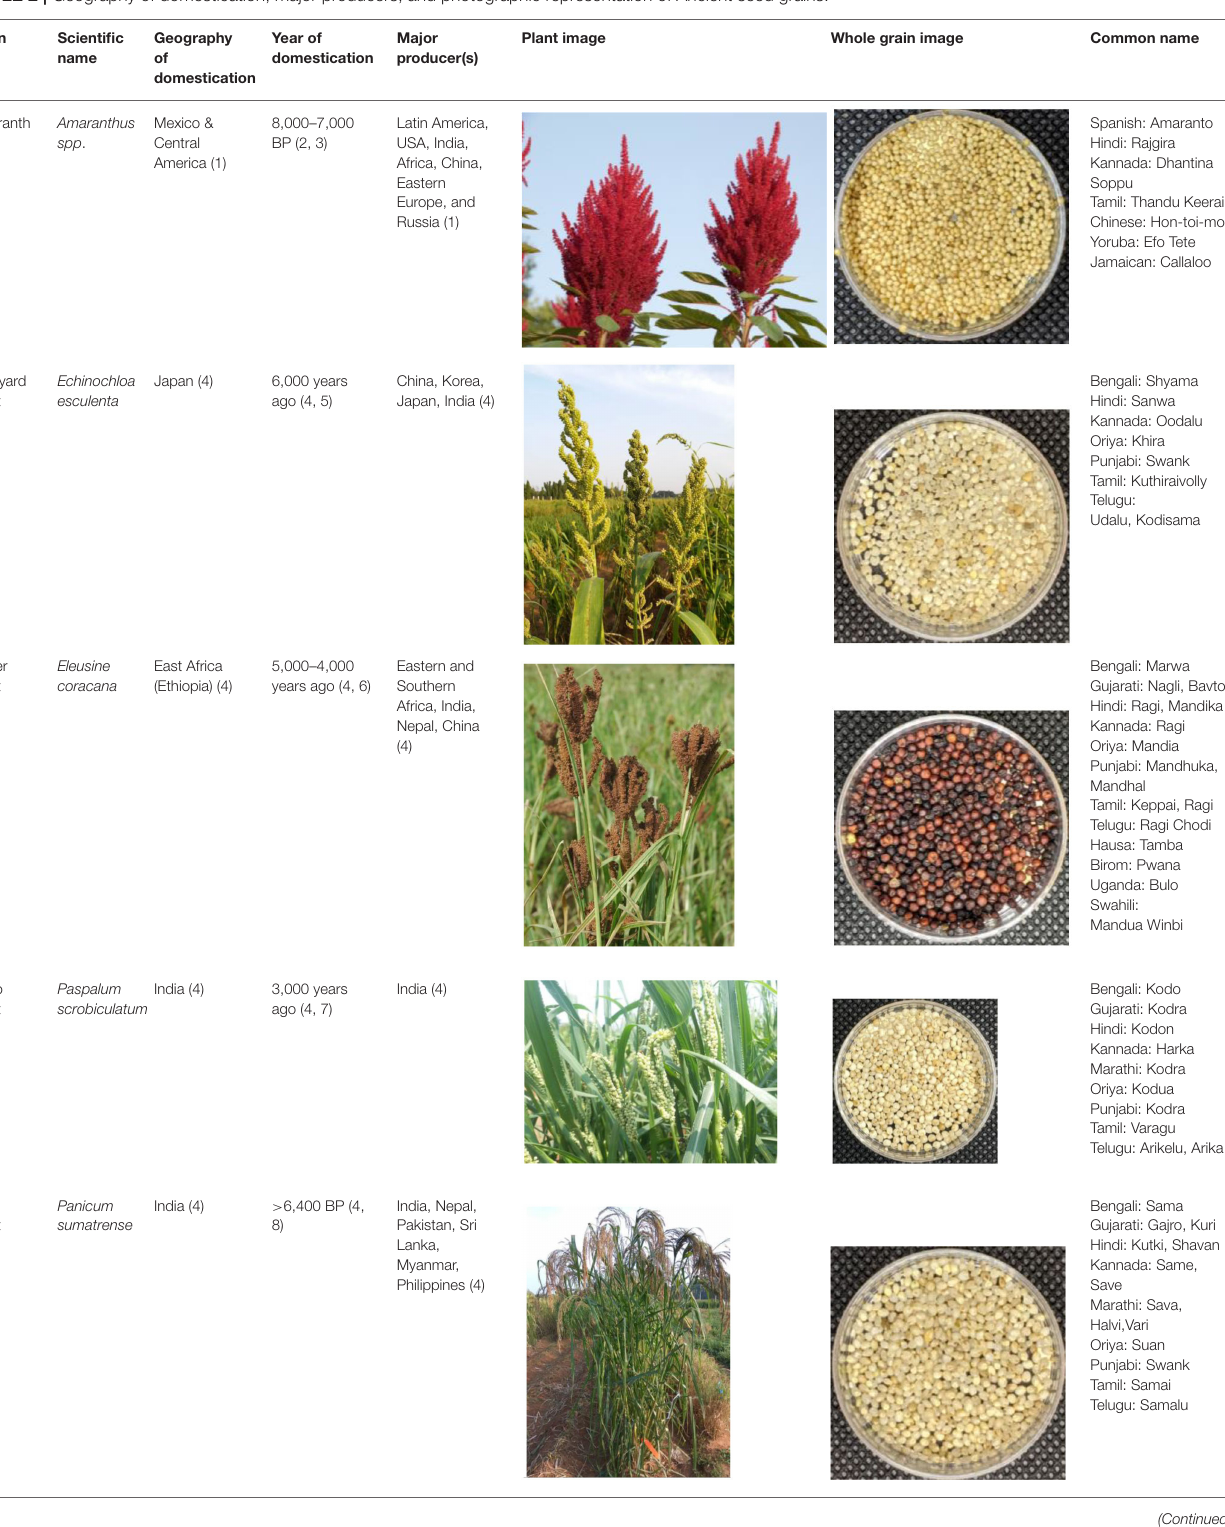
TABLE 2 | Geography of domestication, major producers, and photographic representation of Ancient seed grains. Grain Scientific name